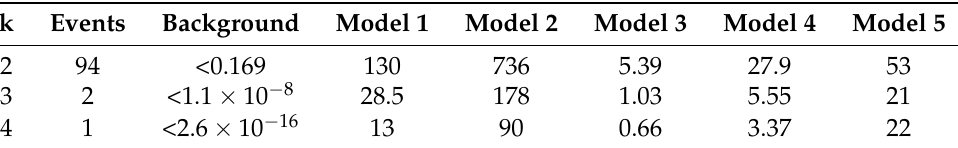
Table 2. Number of events with k = 2–4 signals in the system of four detectors measured during one week and compared to the expectations from the background and predictions from different models, with the assumption that electrons and photons from a cascade can reach the detectors only if they enter into the building through a window.